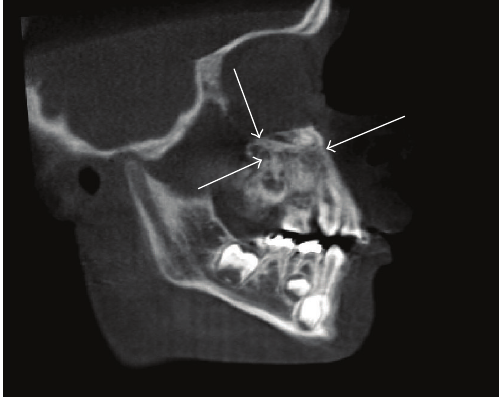
Figure 3: Parasagittal cone beam computed tomography view showing bony changes in the left maxilla with lack of eruption of